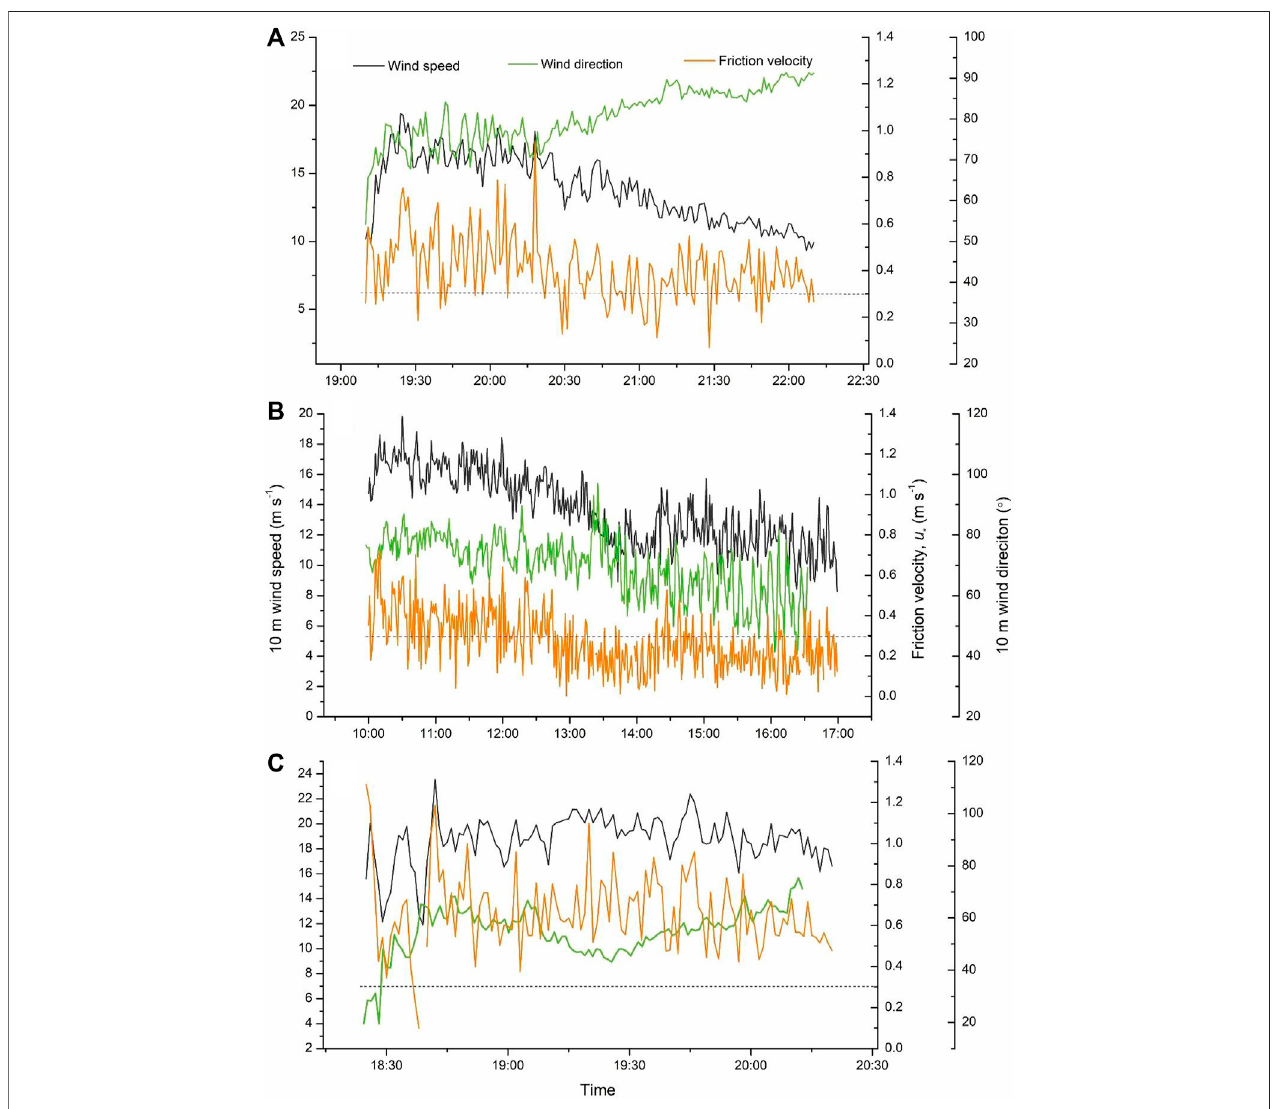
FIGURE 2 | Variation of wind speed and direction at a height of 10 m and friction velocity with time during the three transport events. (A) 20180502 event, (B) 20180504 event, and (C) 20180507 event. The dash line refers to the threshold friction velocity u*t (0.30 m s − 1 ).